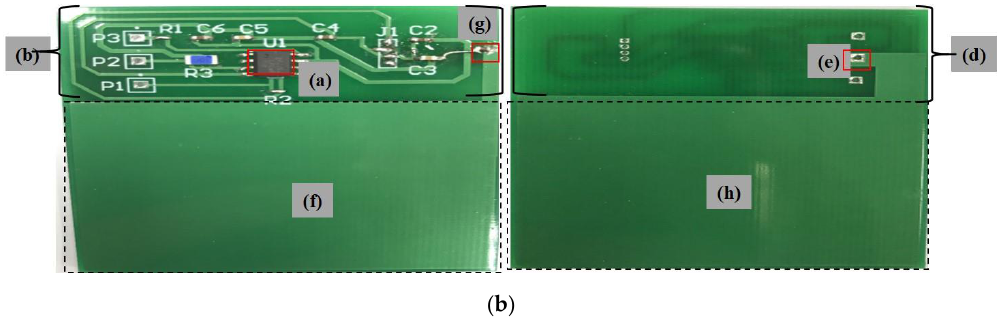
Figure 2. ( a ) Cross-section and ( b ) photos of the presented capacitive electrodes.